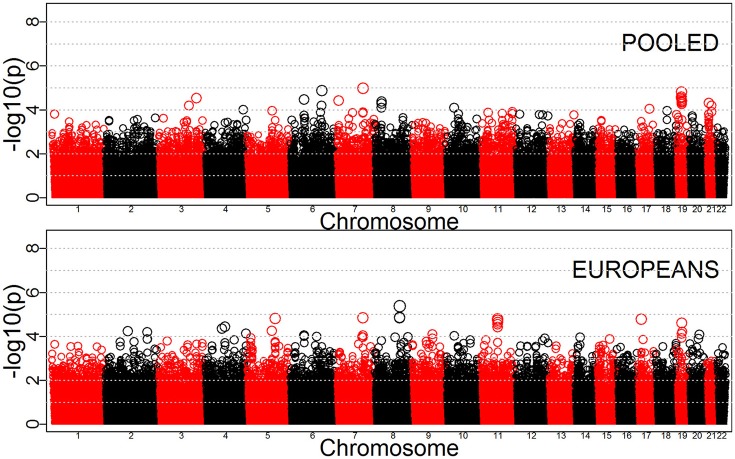
Manhattan plots for GxSmoke effects in the pooled and Europeans-only analyses.